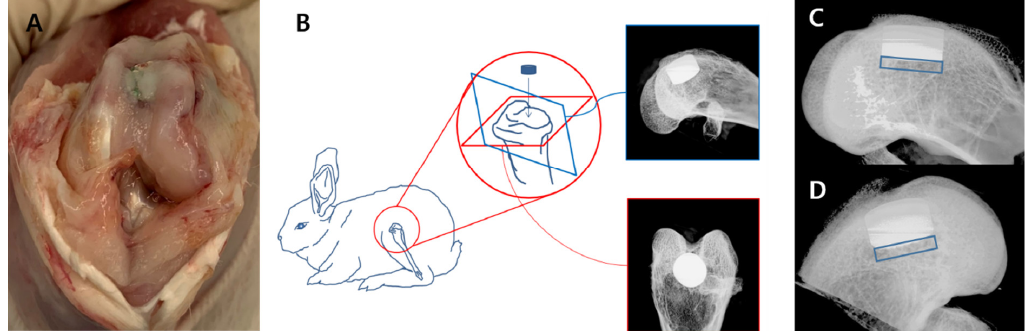
Figure 3. A : After euthanizing, the right side of the distal femur was harvested. B : Axial and lateral Figure 3. A: After euthanizing, the right side of the distal femur was harvested. B: Axial and lateral images were obtained using micro X-ray. C, D: Osteolysis was defined as a low-density area visible images were obtained using micro X-ray. C , D : Osteolysis was defined as a low-density area visible within a 1-mm area from bone-implant contact surface (lateral-view). within a 1-mm area from bone-implant contact surface